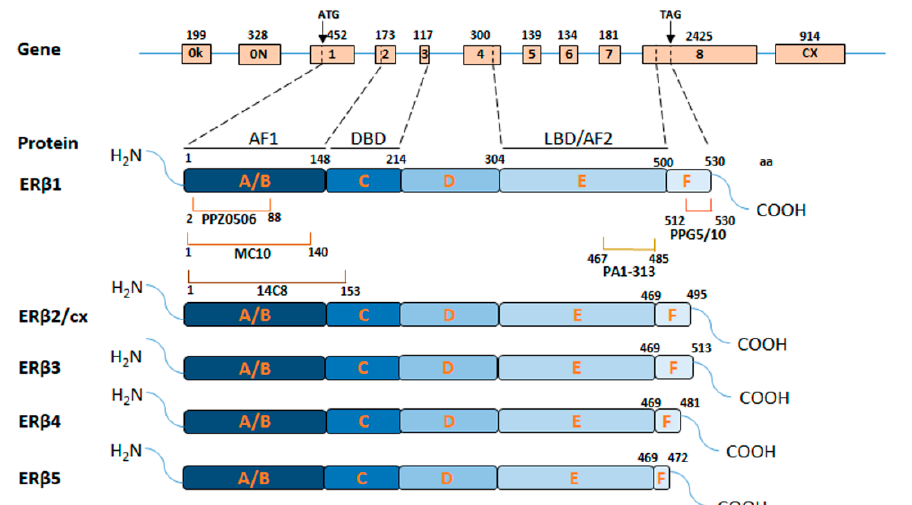
Figure 1. Schematic representation of ER β gene, protein isoforms (ER β 1–5), and most used antibody epitopes. For the gene, 0K and 0N represent two promoters at the 5 ′ end of the gene, exons 1–8 are represented by boxes, and the introns are represented by lines. CX represents a 3 ′ non ‐ coding exon present in the long form of ER β 2 protein (ER β cx). Size (bp) of each exon is showed by numbers above boxes, arrows indicate the start (ATG) and the stop (TAG) codons, and dotted lines link gene regions with the encoded protein domains. For protein isoforms, from N-terminus to C-terminus, A / B: activation function 1 (AF1) domain, C: DNA-binding domain (DBD), D: hinge domain, E: ligand-binding domain (LBD) or activation function 2 (AF2) domain, F: C-terminal domain. Square brackets show regions targeted by antibodies PPZ0506, MC10, 14C8, PPG5 / 10, and PA1-313. Numbers indicate the amino acids of the